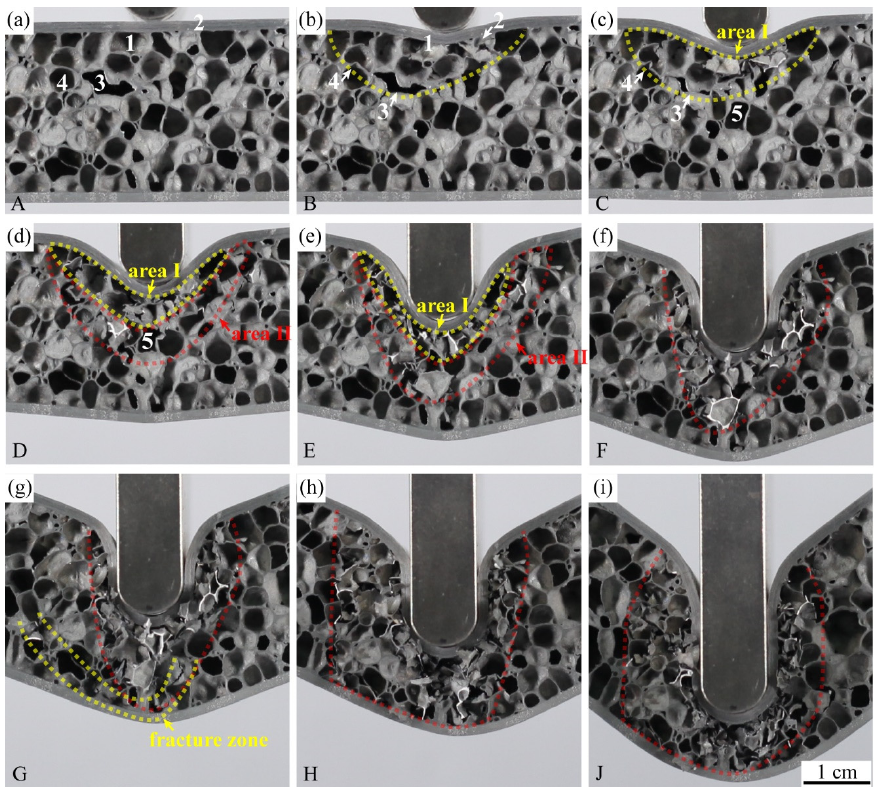
Figure 16. Deformation state of AFS under different compression amounts: ( a ) 0 mm, ( b ) 2.52 mm, ( c ) 5.37 mm, ( d ) 11.39 mm, ( e ) 20.87 mm, ( f ) 28.85 mm, ( g ) 30.84 mm, ( h ) 38.84 mm, ( i ) 52.61 mm.